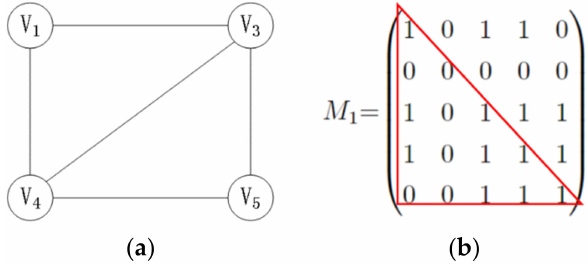
Figure 1. ( a ) Specific examples of G 1 ; ( b ) matrix M 1